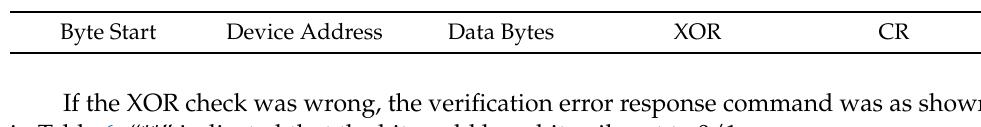
Table 5. MCU verification correct response command.